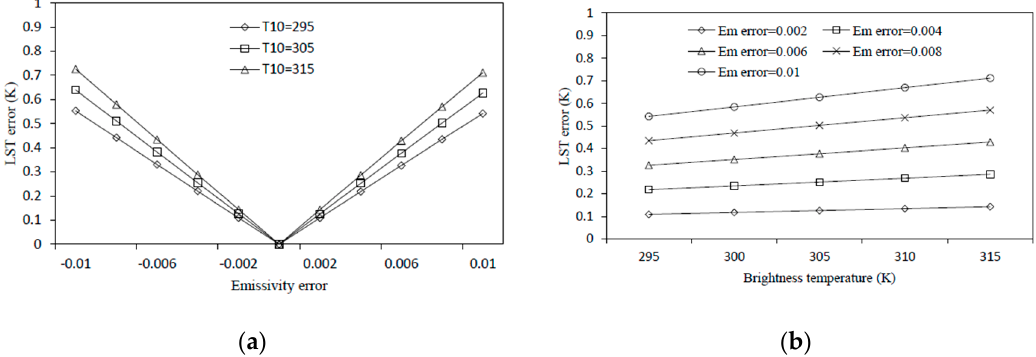
Figure 5. The LST (Land Surface Temperature) estimation error of mono-window algorithm as a result of the estimation error in LSE. ( a ) LST error against Emissivity error, and ( b ) LST error against brightness temperature for different emissivity error.